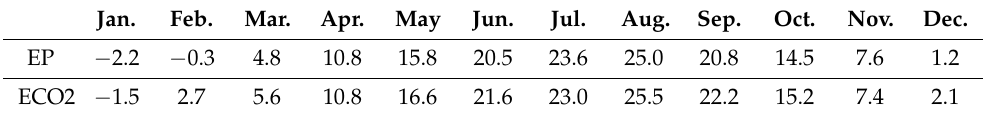
Table 3. EnergyPlus and ECO2 monthly average outdoor temperature ( ◦ C) comparison (Incheon). Jan.